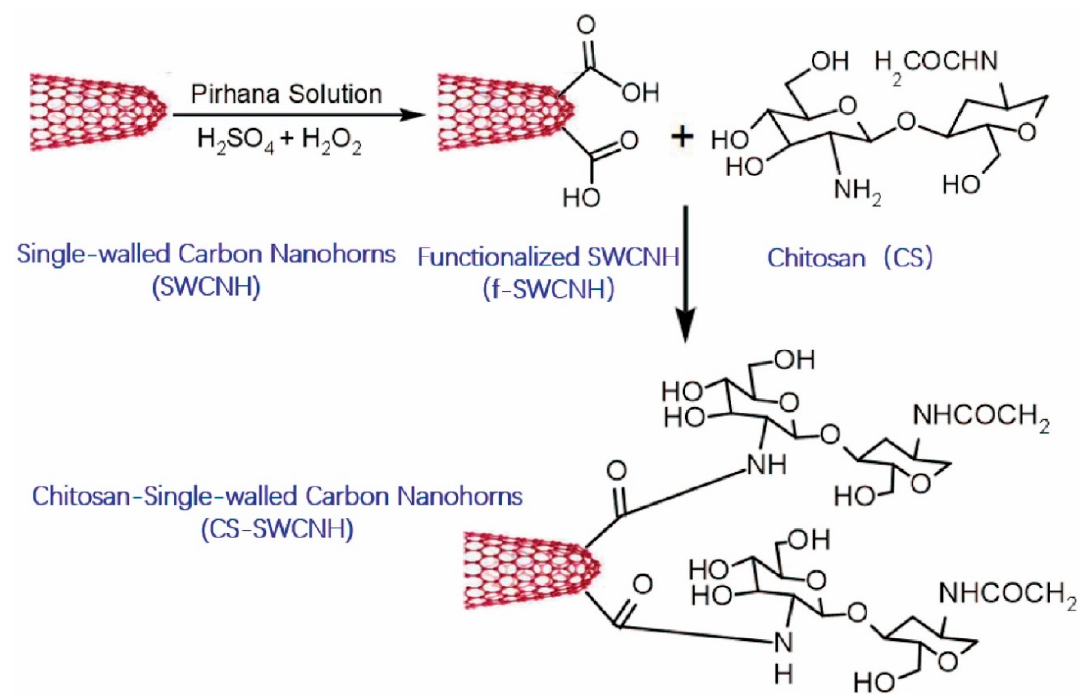
Figure 6. Schematic representation of subsequent covalent reaction between single-walled carbon nanohorns (SWCNH) and the amine group of chitosan (CS) during CS-SWCNH hybrid scaffolds fabrication.